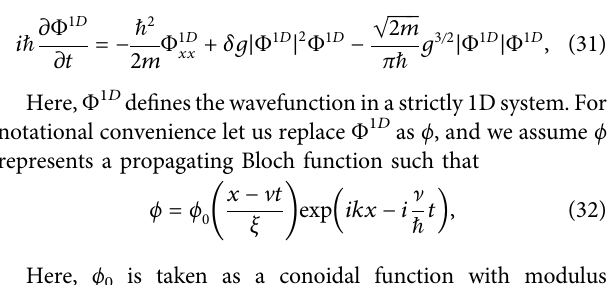
FIGURE 10 | (Color online) The variation of the rms size of the droplets with the modulation of the trapping potential. The solid blue line, the red solid squares, and the black solid circles denote κ = 0.1, 0.5, and 0.9, respectively. The shaded region describes the crossover area.